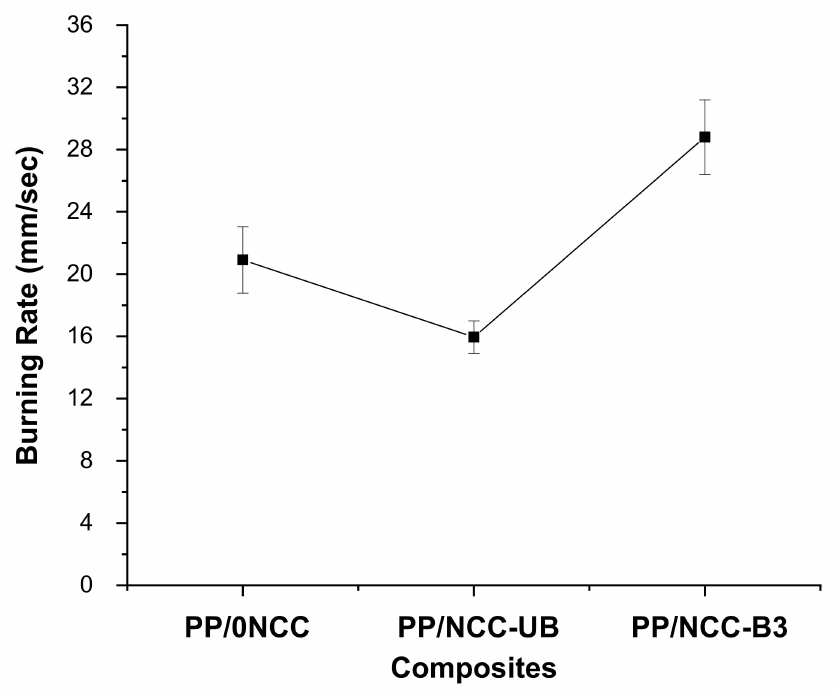
Figure 9. The burning rate of kenaf core nanocomposites for reinforced bleached and un- bleached